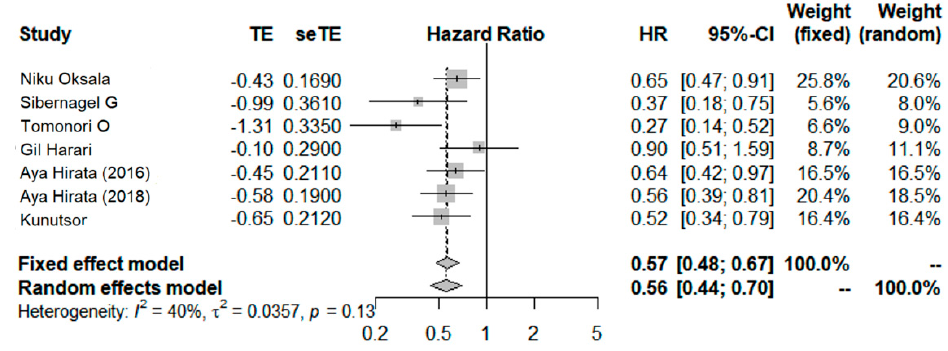
Figure 5. Forest plot for pooled HRs and 95% CIs of CVD mortality for lowest versus highest categories of serum High-density lipoprotein cholesterol (HLD-C) level [20–22,26,27,29,33]. The overall effect was obtained from a random-effect model.